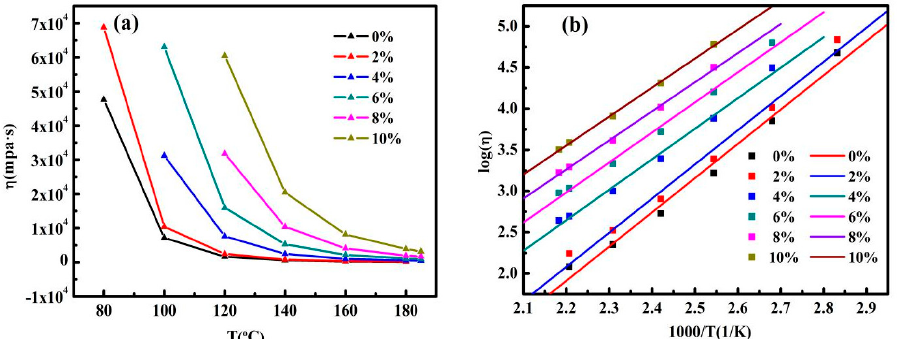
Figure 11. ( a ) Temperature dependence of viscosity of control asphalt and GMAs. ( b ) log ( η ) versus reciprocal temperature for control asphalt and GMAs.